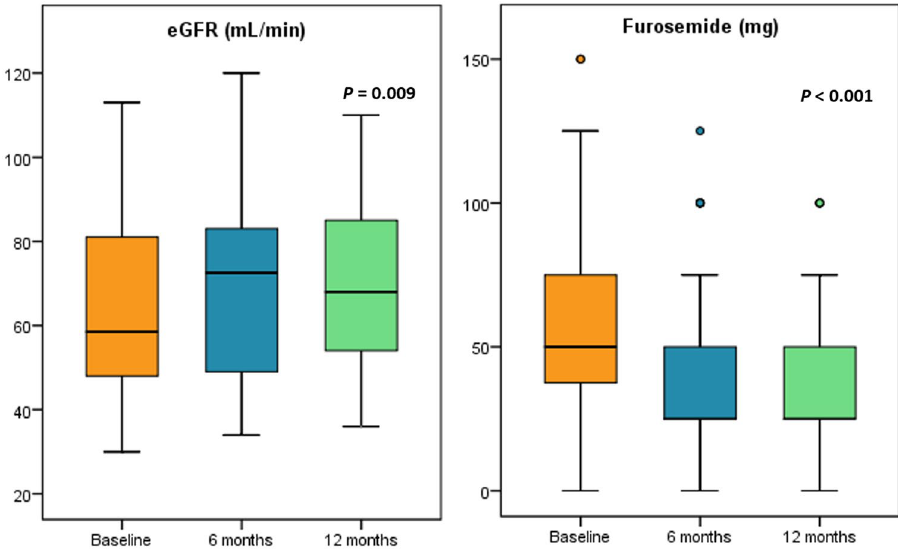
Figure 5. Box plots showing the changes in term of eGFR and furosemide dose regimen from baseline to 6- and 12-months follow-up in patients treated with Sacubitril/Valsartan. eGRF, estimated glomerular filtration